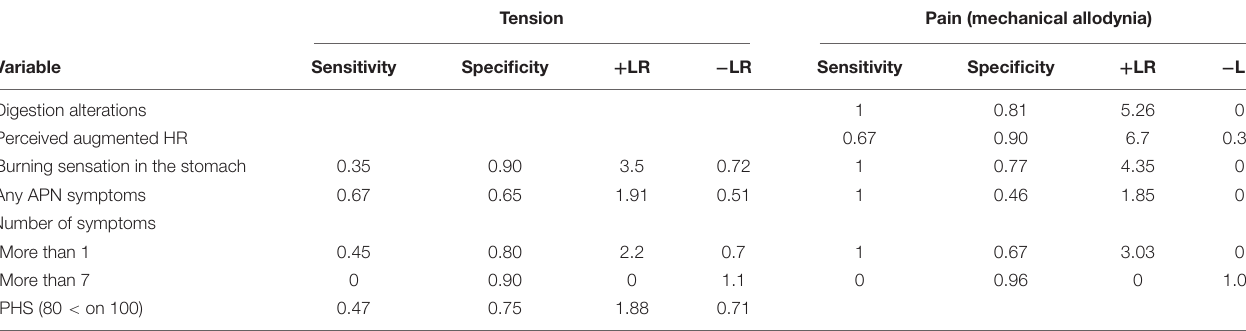
TABLE 2 | The vagus nerve neurodynamic test accuracy. Tension Pain (mechanical